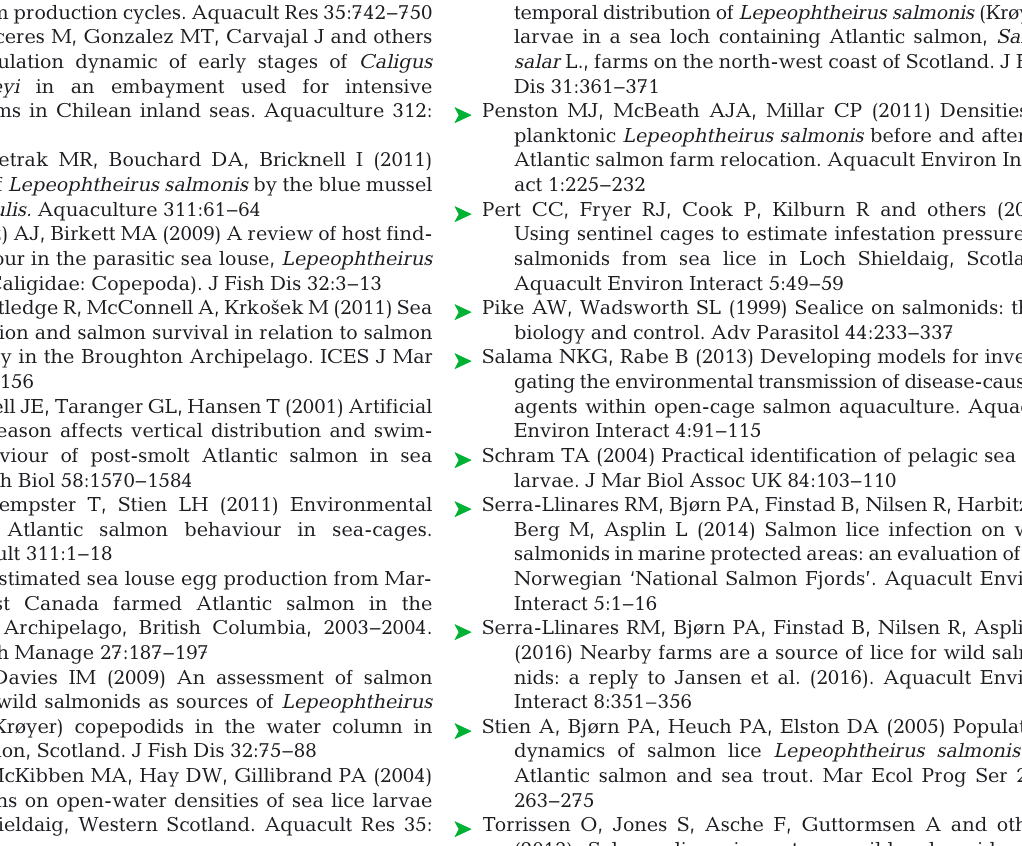
dynamics of salmon lice Lepeophtheirus salmonis on Atlantic salmon and sea trout. Mar Ecol Prog Ser 290: 263−275 Torrissen O, Jones S, Asche F, Guttormsen A and others (2013) Salmon lice—impact on wild salmonids and salmon aquaculture. J Fish Dis 36: